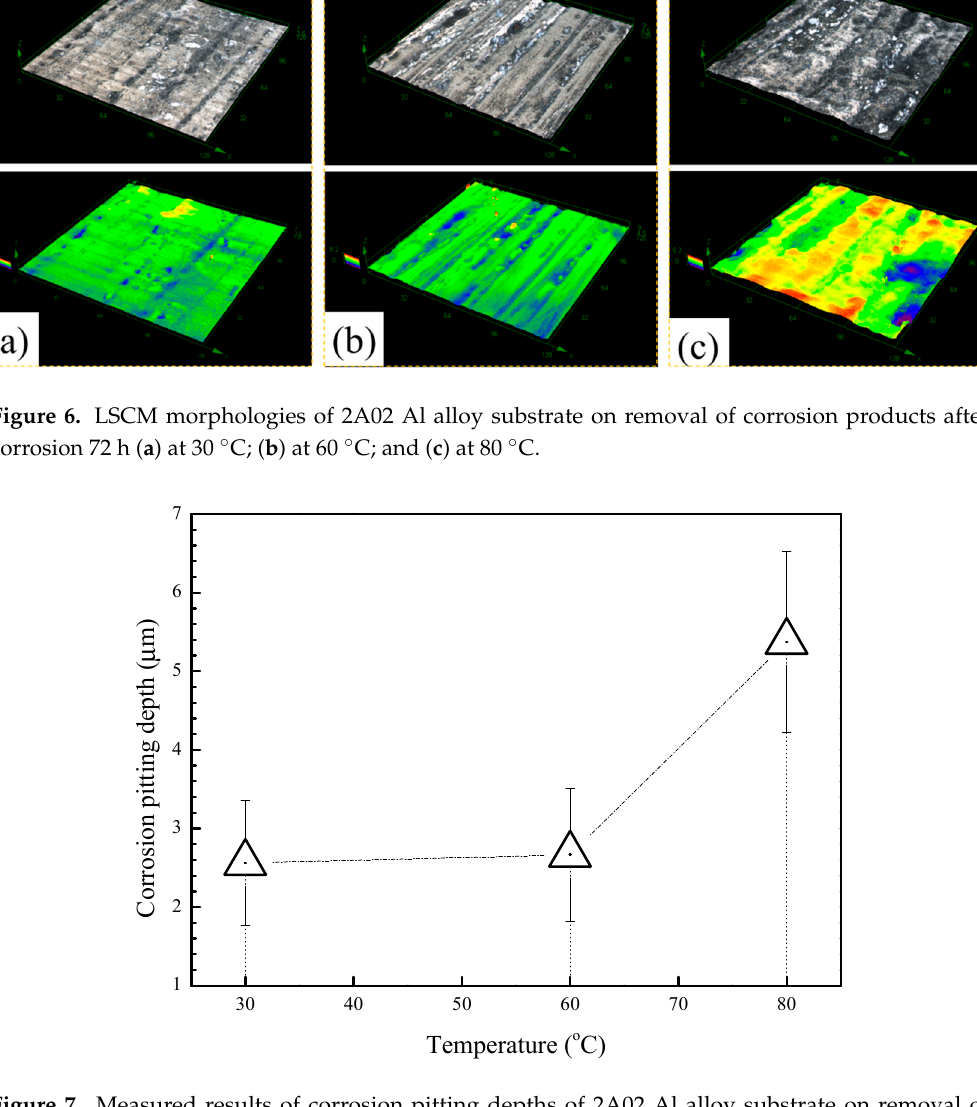
Figure 7. Measured results of corrosion pitting depths of 2A02 Al alloy substrate on removal of corrosion products after corrosion 72 h at 30 °C, 60 °C and 80 °C. This result corresponds to Figure 6 and was obtained from measured results by LSCM using our own software OLS4000.